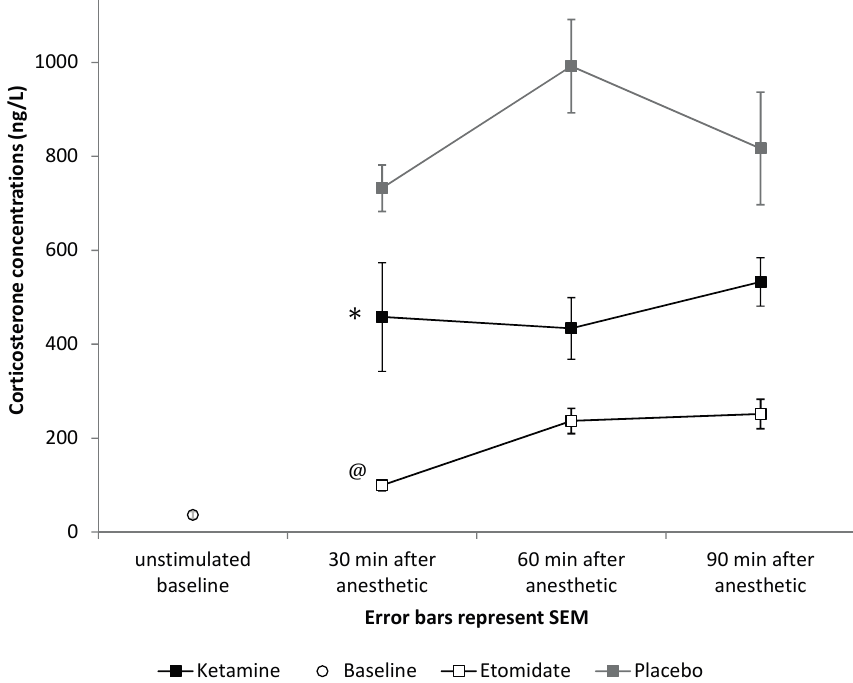
Figure 6. Effects of a bolus of 4 mg/kg of etomidate or 40 mg/kg of ketamine on free plasma corticosterone concentrations compared to placebo (saline bolus). After both 4 mg/kg of etomidate and 40 mg/kg of ketamine, significantly lower responses to ACTH were observed during the full study period (* p < 0.001 for mean ACTH response after ketamine compared to placebo, and @ p < 0.001 for mean ACTH response after etomidate compared to placebo). Error bars represent the